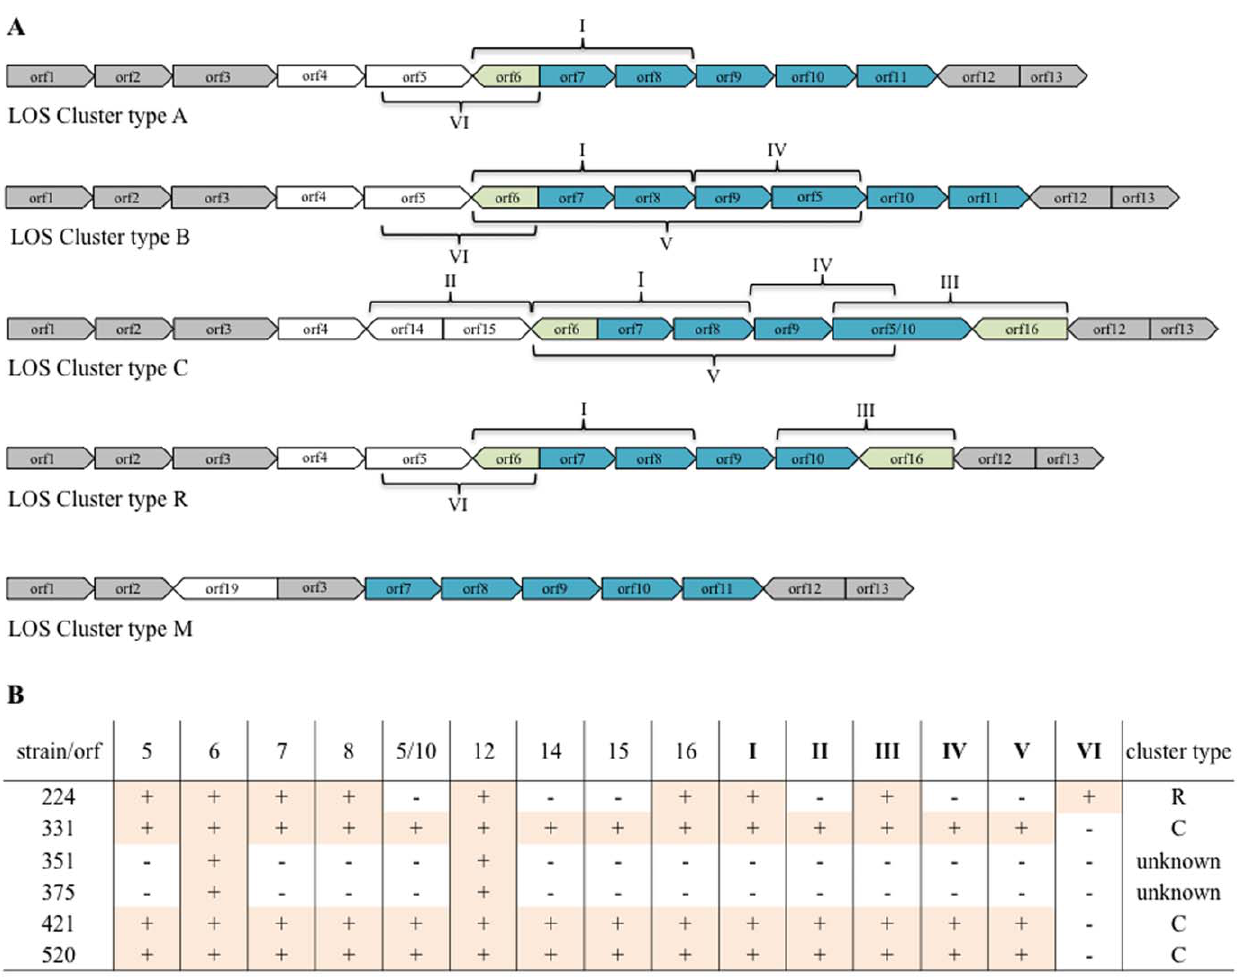
Figure 1. C.jejuni LOS biosynthesis cluster typing. A) LOS biosynthesis cluster types A, B, C, R & M and amplified DNA fragments that were used for cluster identification. B) Results of independent (orf5, orf6, orf7, orf8, orf5/10, orf12, orf14, orf15 & orf16) and overlapping (I: orf6-orf8; II: orf14–15; III: orf5/10–16; IV: orf9-orf5/10; V: orf6-orf5/10; VI orf5-orf6) PCR amplifications from the genomes of C. jejuni isolates 224, 331, 351, 375, 421 and 520. Plus ( + ) symbol denotes a positive result of the PCR amplification judged by the correct DNA fragment size and confirmed by dideoxynucleotide sequencing of the amplified DNA fragment. Minus ( 2 ) symbol denotes a negative PCR outcome, suggestive of the gene’s absence or inability to amplify it using low stringency conditions.